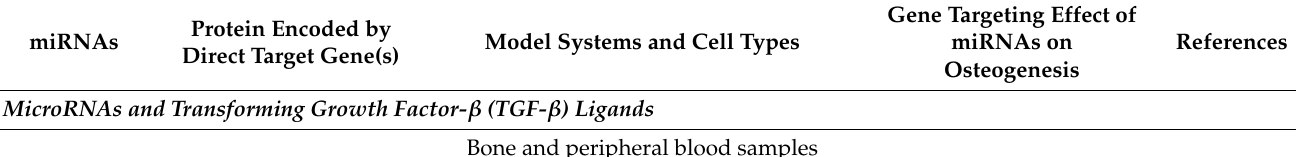
Table 1. List of microRNAs implicated in the TGF- β signalling pathway in various model systems and cell